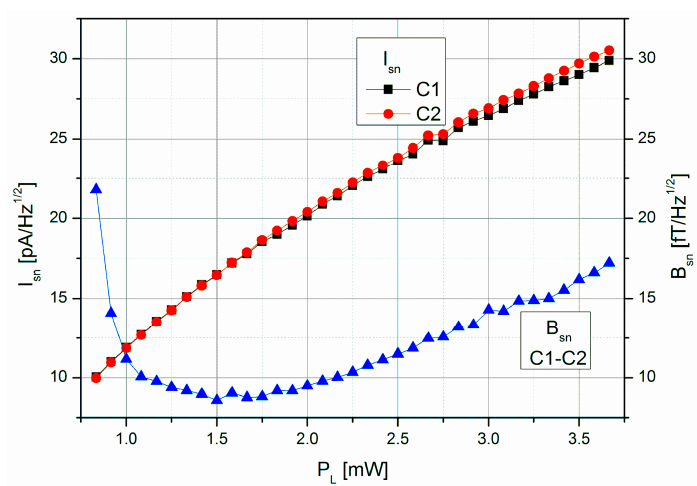
Figure 7. Dependence of the resonance width (half width at half maximum), determined by the relaxation rate Γ , and depth of the two individual cells and the resulting LSD-Mz signal steepness d I d /d f B1 on the laser pumping power P L .